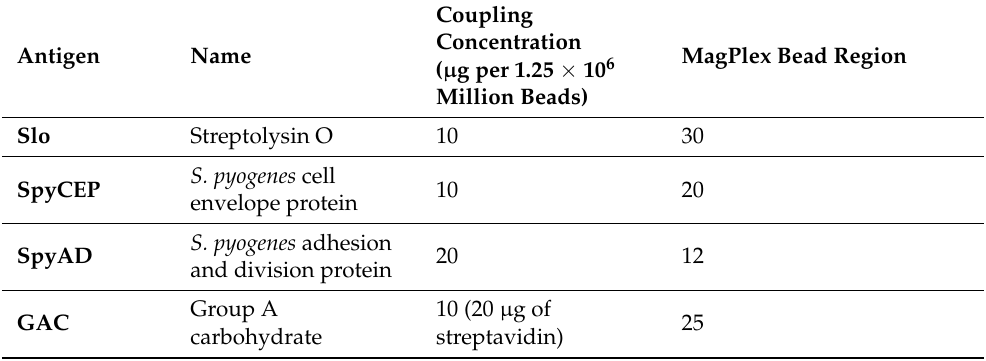
Table A1. Antigen coupling concentration and MagPlex bead region used for each